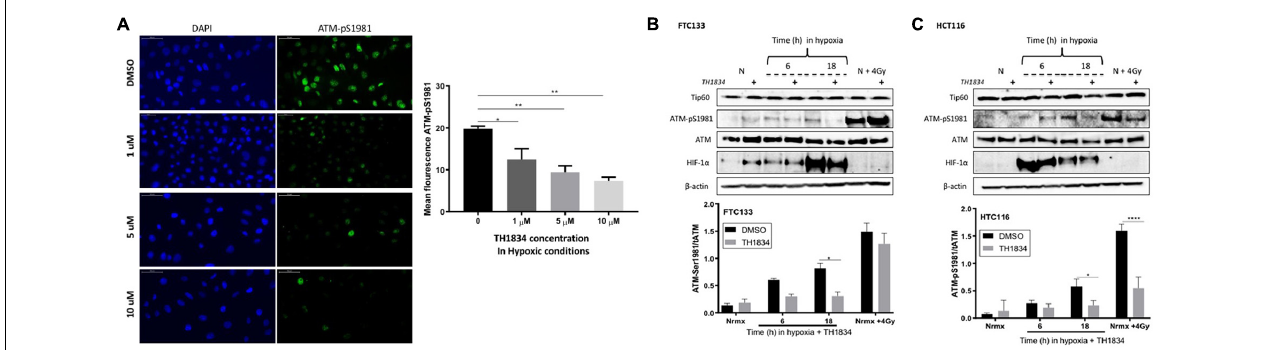
FIGURE 4 | Tip60 mediates ATM auto-phosphorylation in hypoxia. FTC133 cells were incubated with 1, 5 or 10 µ M of TH1834 or DMSO for 18 h in hypoxia (0.1% O 2 ). Cells were stained for ATM-pSer1981 (green) and DAPI (blue). The graph represents ATM-pSer1981 mean fluorescence intensity (A) . FTC133 (B) and HCT116 (C) cells were incubated with or without 10 µ M of TH1834 in normoxia (21% O 2 ) or hypoxia (0.1% O 2 ) for 6 or 18 h prior to lysis and Western blotting. Treatment with TH1834 is indicated with the symbol (+). Normoxia is indicated with an N and cells irradiated with 4 Gy as N + 4 Gy. HIF-1 α was used as a control for hypoxia and β -actin as a loading control. The graphs represent the densitometry of ATM-pSer1981 protein level standardized to the total amount of ATM and the loading control in the presence of TH1834 (gray) or DMSO (black). Three independent experiments were performed and the bar represents the mean ± SEM. * p ≤ 0.05, ** p ≤ 0.01, **** p ≤ 0.0001.